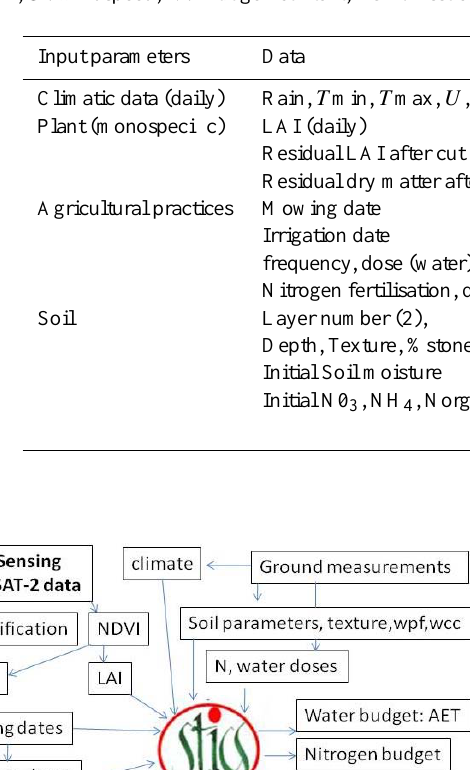
Table 3. Summary of the main inputs necessary for STICS ( T min, max: minimum and maximum air temperature, HR: air moisture, Rg: global radiation, U : windspeed, N : nitrogen content, ASA: Association for water management).